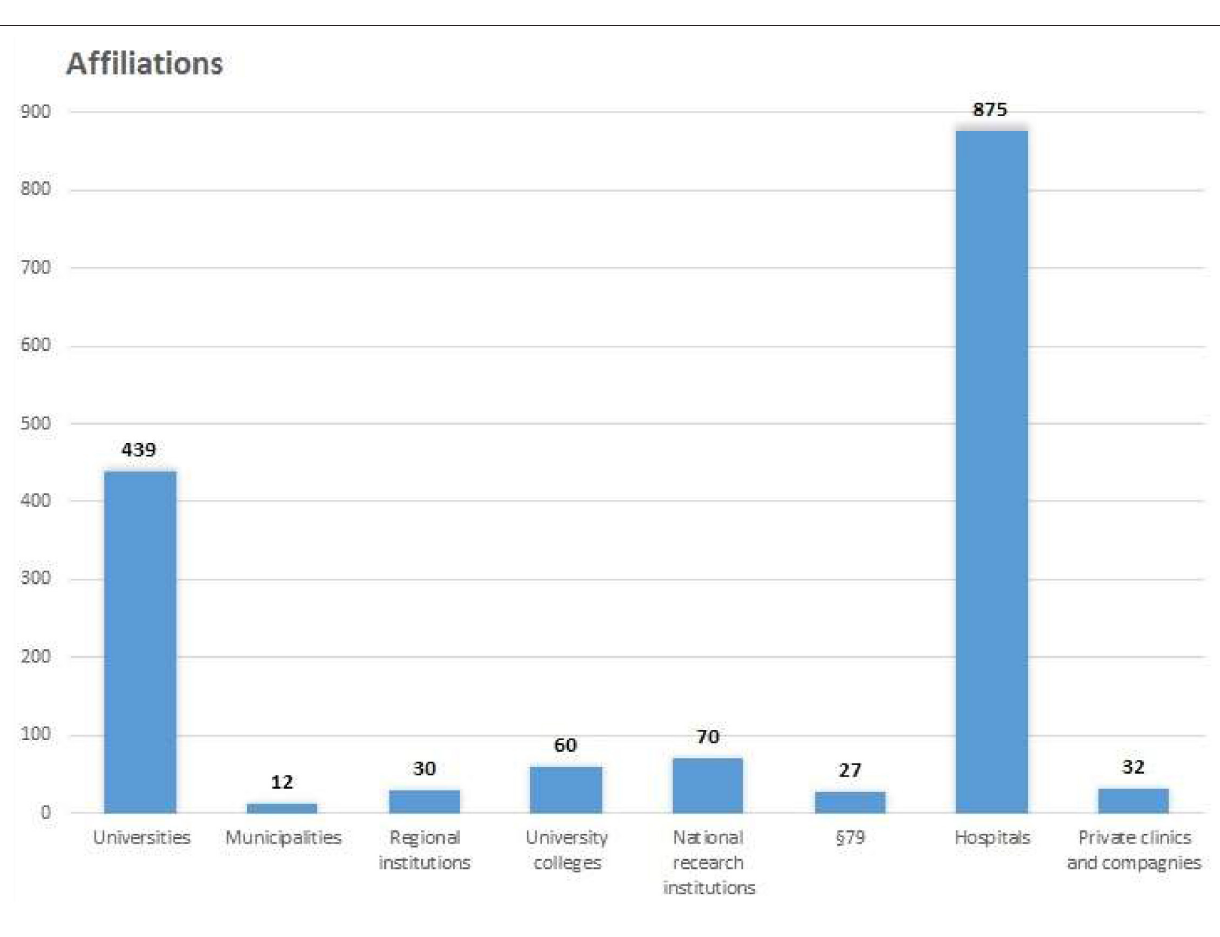
FIGURE 4 | Number of affiliations.